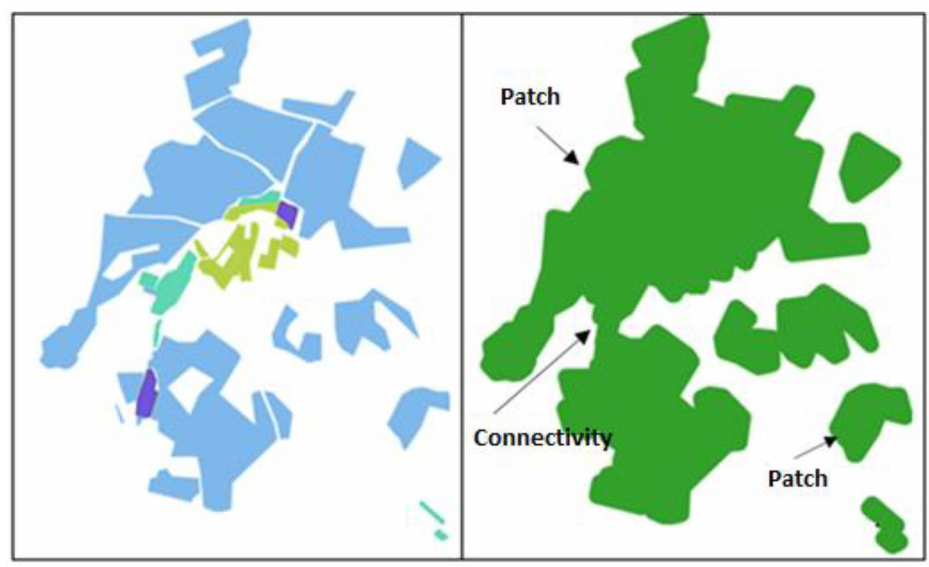
Figure 2. Map on left shows unconnected patches, while map on the right groups patches together using the dilation/erosion method.